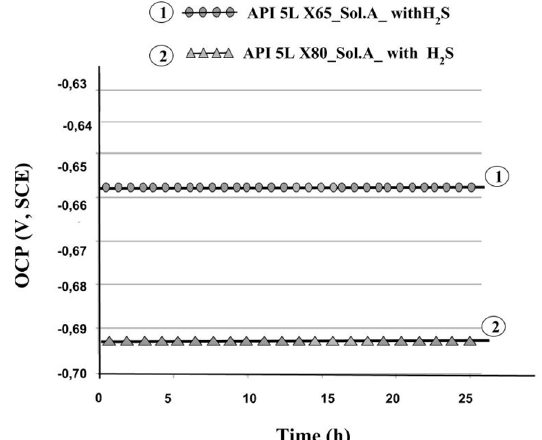
Figure 7. Potentiodynamic polarization curves for API 5L X65 and API 5L X80 steels in deaerated solution A, NACE TM0284 (2011), without and with H S saturation. Experimental Procedure 1. 2